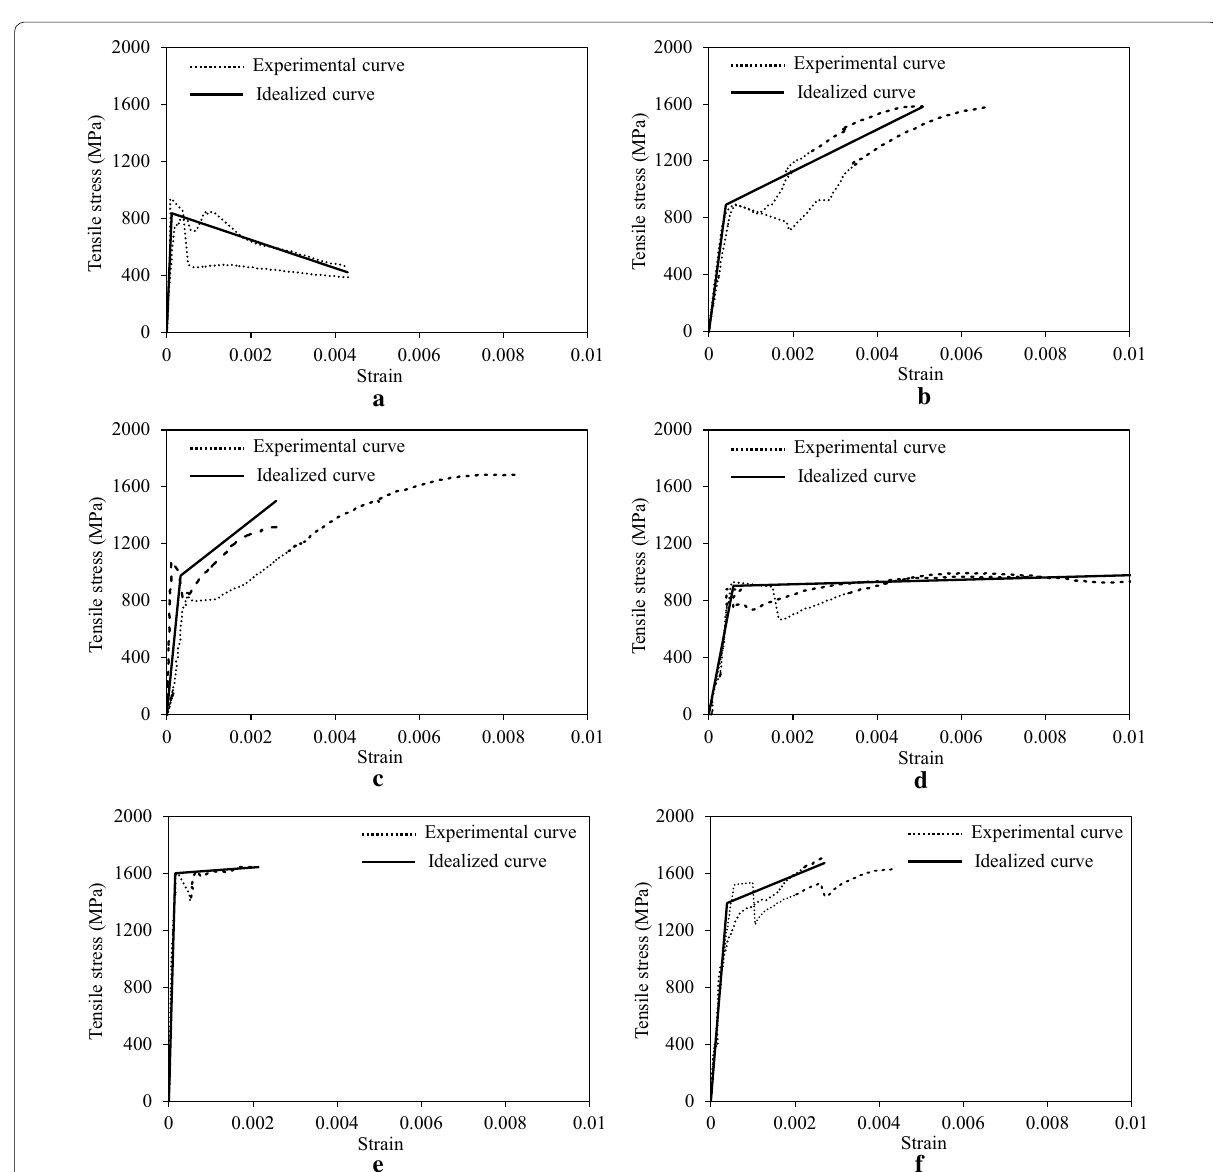
Fig. 11 Idealized and experimental stress–strain curves of TRM test specimens in this study. a BASE, b SPREAD, c TAB, d REBAR, e L_COAT, f SL_